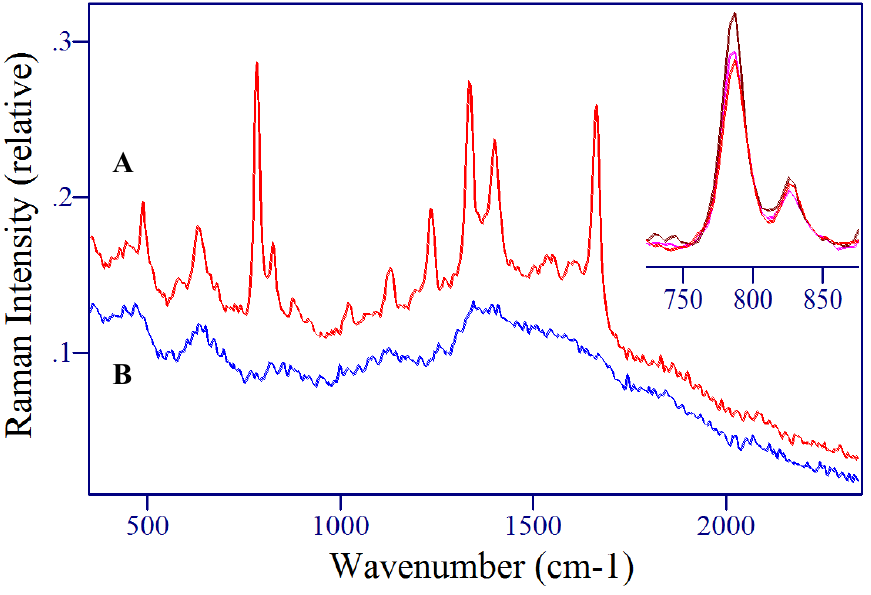
Figure 13. SER spectra of 5-FU in pH adjusted saliva for A) 50 μ g/mL 5-FU and B) un-